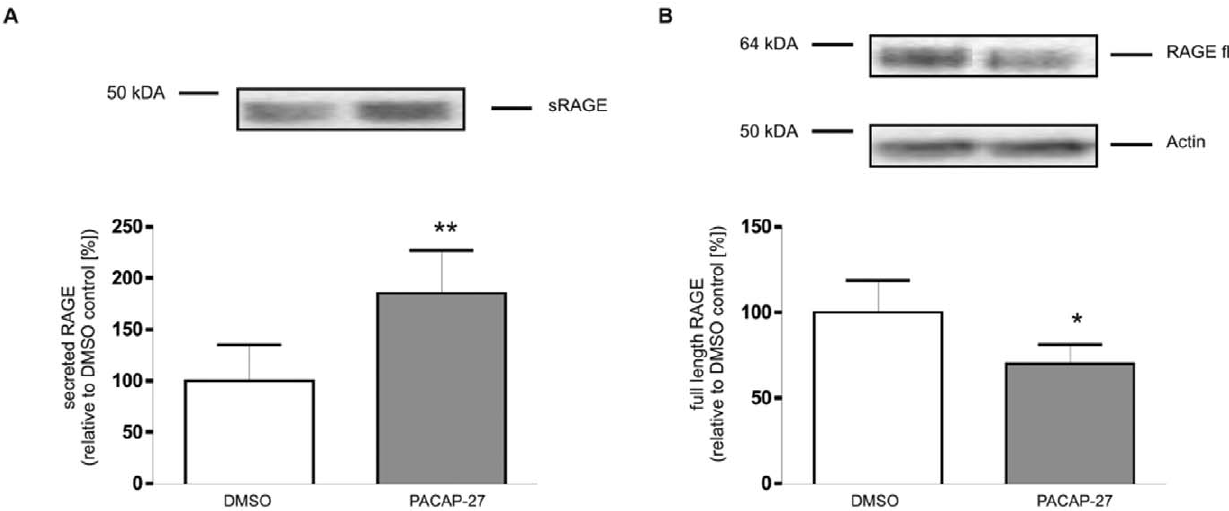
Figure 2. Induction of RAGE shedding at the cell surface with PACAP-27. Cell-surface proteins of full-length RAGE and PAC1 coexpressing cells (PAC1/RAGE cells) were biotinylated using a membrane-impermeable biotinylation reagent. PACAP-27 and control treatment was then performed for 2 h. The amount of secreted biotinylated (A) and cell-anchored biotinylated RAGE (B) was determined separately under constitutive or PACAP-stimulated conditions after isolation of biotinylated proteins. RAGE was detected by Western blotting using antibody Mab5328 and ECL; typical blots are shown. Left image, amount of secreted biotinylated RAGE; right images, cell surface-located biotinylated RAGE and actin in total cell lysates. For quantification the experiments were performed in triplicates. Shown are the mean effects 6 S.D., significance was determined by the One-way ANOVA Bonferroni test (* = P , 0.05; ** = P , 0.01).